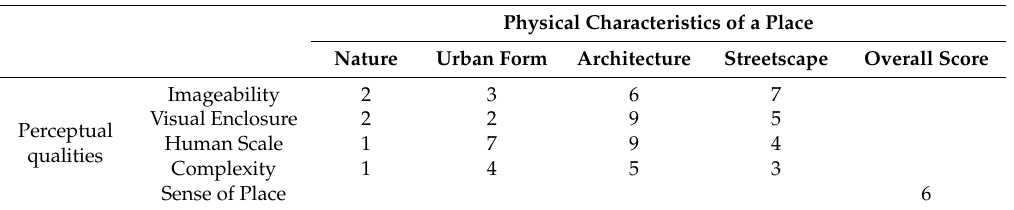
Table 2. Panel auditing score sample from one single panelist for one site.